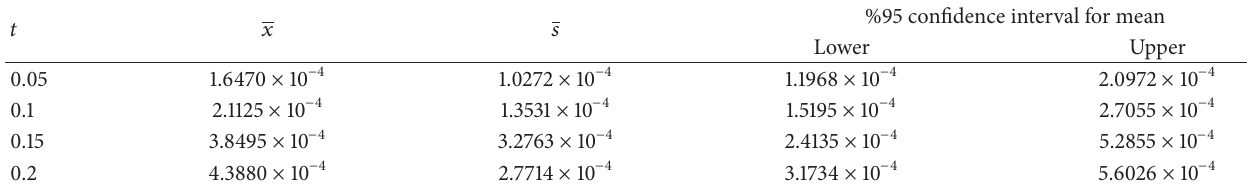
Table 1: Mean, standard deviation, and confidence interval for error mean ( 𝑇 = 0.25 , 𝐻 = 2/3 ).